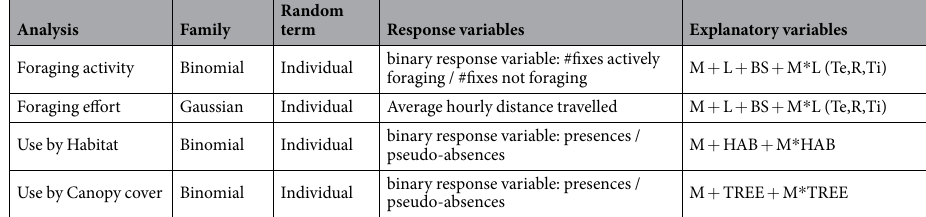
Table 3. Summary of our main GLMM analyses examining morph specific foraging activity and foraging effort across the ambient light spectrum, as well as level of habitat selection, using six habitat categories (HAB) and percentage tree canopy closure (TREE). Explanatory variables were M = morph type (dark or white) L = light level (W/m 2 ) and breeding stage (BS). Additional analyses (in parentheses) were also undertaken for foraging activity and effort where light level was replaced with either temperature (Te), rainfall (R) or time (and time 2 )